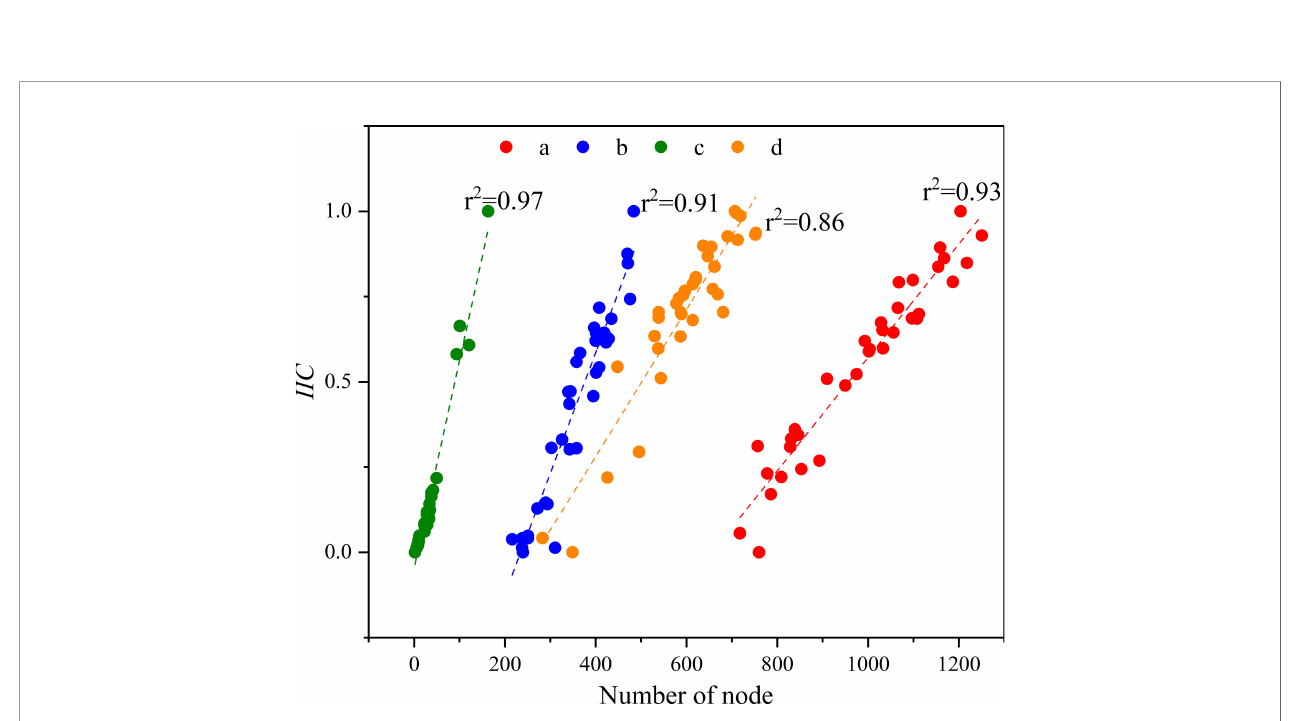
FIGURE 5 | The relationship between the geometry of the tidal channel networks and the longitudinal hydrological connectivity (a represent the whole scale, b, c and d represent erosion zone, oil fi eld zone and deposition zone